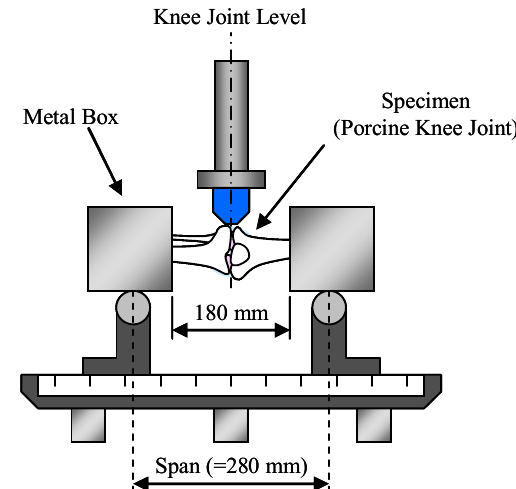
Fig. 2 Geometry of specimen. The knee joint of length 180 mm was exposed. The span length of the three-point bending support was fixed at 280 mm. The impactor was launched toward the lateral side of the